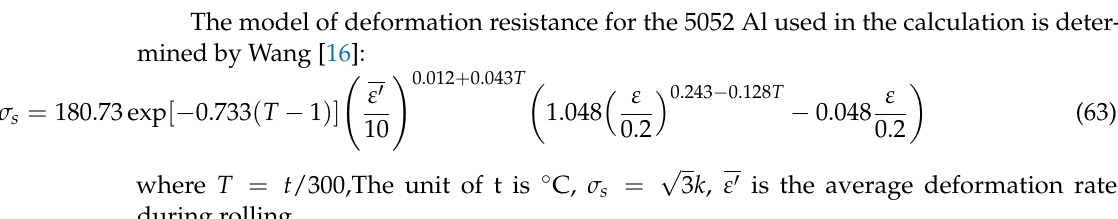
Figure 7. ( a ) Two-high asynchronous variable thickness experimental rolling mill; ( b ) Mill control